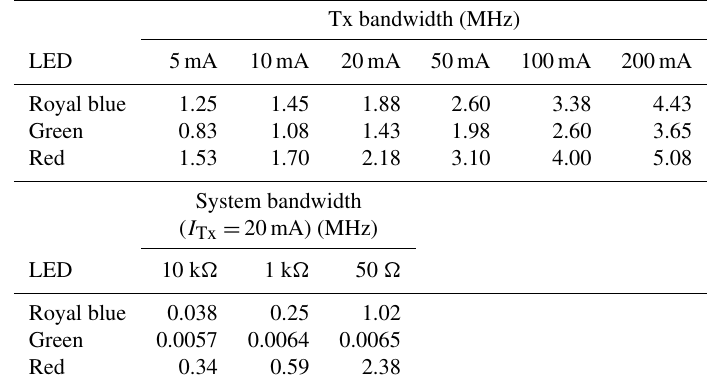
Figure 14. 3dB bandwidth of different LEDs as transmitter (Tx bandwidth) for different bias currents and of complete systems consisting of two LEDs of the same type (system bandwidth) for different load resistances: (a) Tx bandwidth – royal blue LED; (b) Tx bandwidth – green LED; (c) Tx bandwidth – red LED; (d) system bandwidth – royal blue LED; (e) system bandwidth – green LED; (f) system bandwidth – red LED. Table 6. 3dB bandwidths of the different LEDs as transmitter and